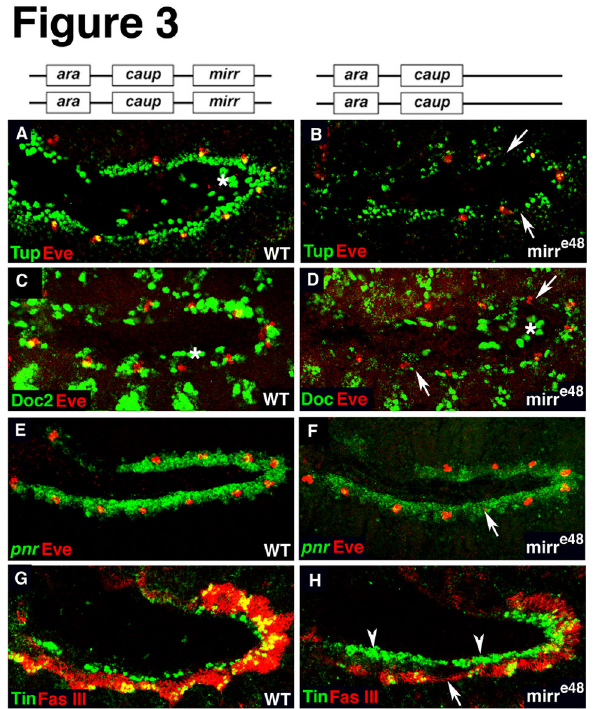
Figure 3. Loss of mirr affects the normal expression of early cardiac transcription factors. (A-D) mirr mutants are characterized by a reduction of (B) Tup- and (D) Doc- expressing cells (arrows). Asterisks in A, C and D indicate expression of Tup or Doc 2 in the amnioserosa. (E, F) pnr mRNA expression is not affected in mirr mutants. The arrow in F points to a missing Eve cell cluster. (G, H) Images are merged optical sections of double immunostainings for FasIII and Tin-expressing cells that appear yellow in the visceral mesoderm. mirr mutants exhibit an increase in Tin-expressing cells in the cardiac region (arrowheads). FasIII expression is slightly reduced in some embryos (arrow). All images show lateral views of stage10/11 embryos. The genetic background is depicted in the drawing above each column.